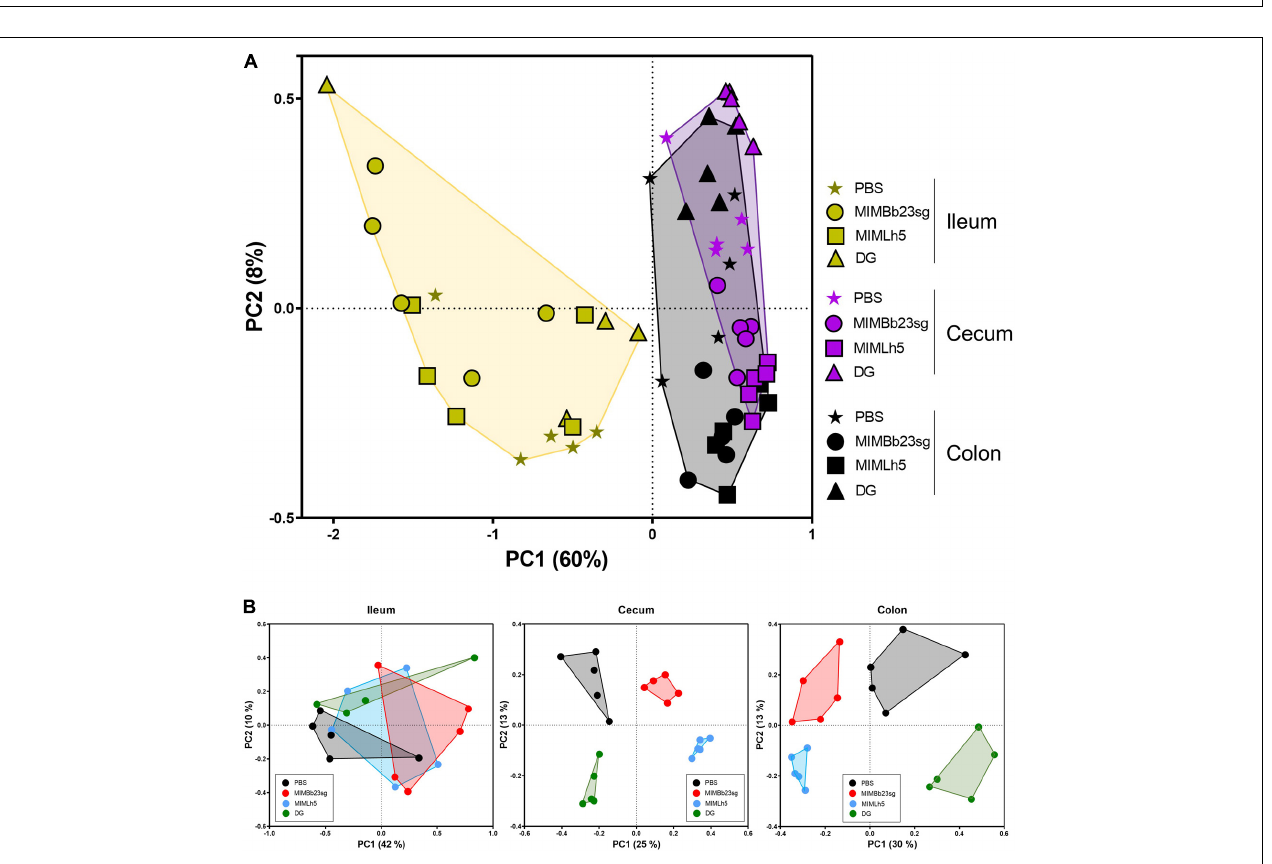
FIGURE 2 | Inter sample ( β -) diversity of the microbiota in mouse intestinal sites shown as principal coordinates analysis of generalized UniFrac distances ( α = 0.5) based on OTU abundances. Every symbol in the graphs refers to a single mouse. The first two coordinates (PC1 and PC2) are displayed with the percentage of explained variance in brackets. The analysis was performed with sample considered all together (A) or separated by intestinal site (B) .